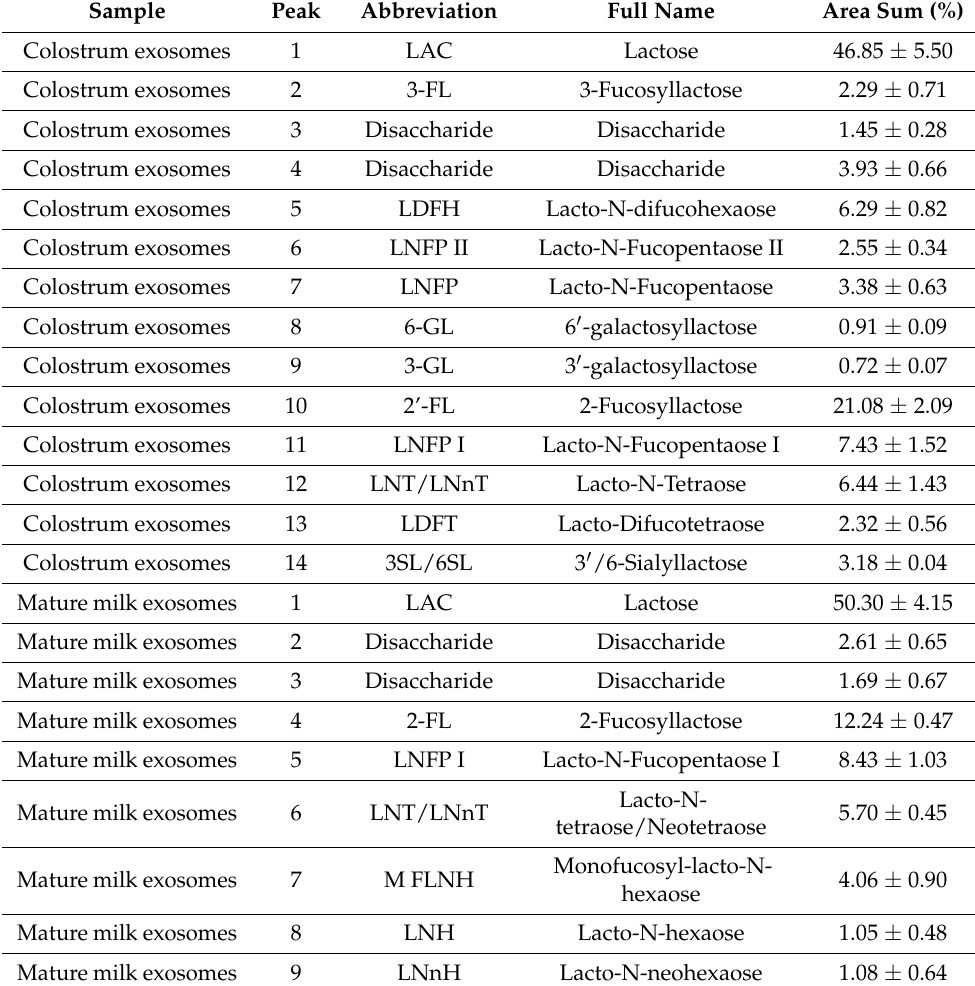
Table 1. The oligosaccharide profile of those capsulated in colostrum and mature milk